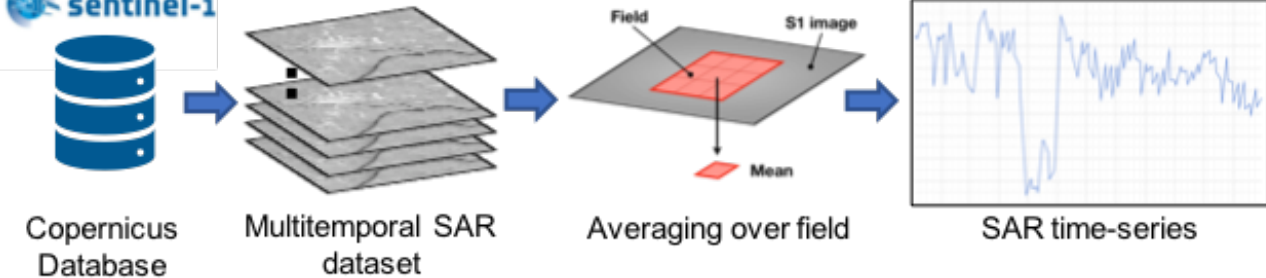
Figure 3. Procedure for generation of SAR backscatter